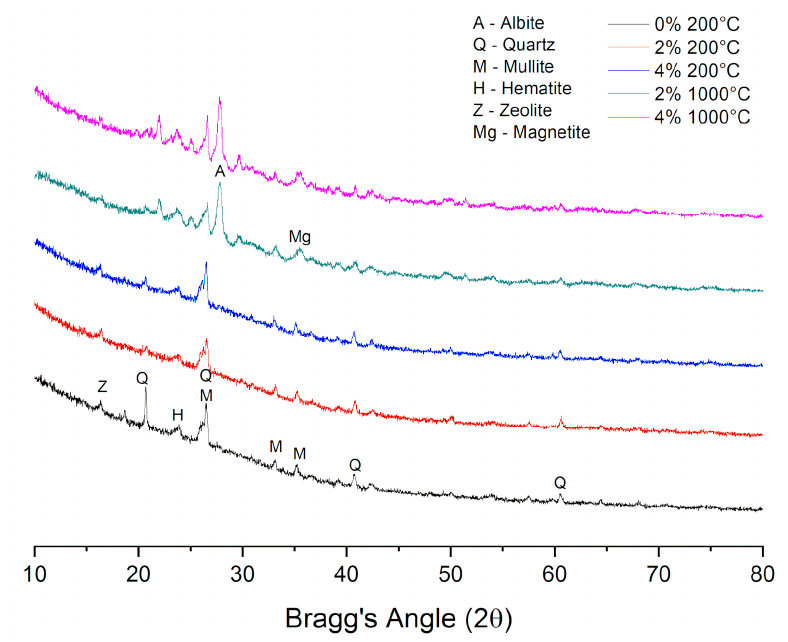
Figure 8. XRD patterns of fly ash geopolymers with varying silica fume content addition after being exposed to 200 °C and 1000 °C.